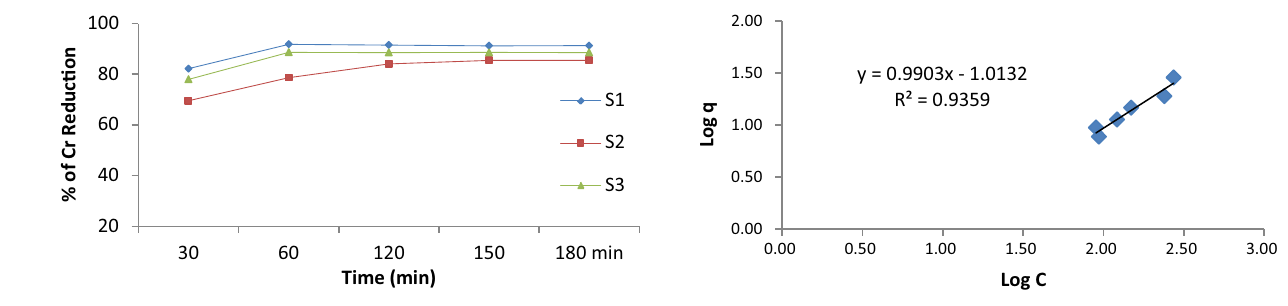
Fig. 12 Effect of contact time on Cr removal (Nur-E-Alam et al.